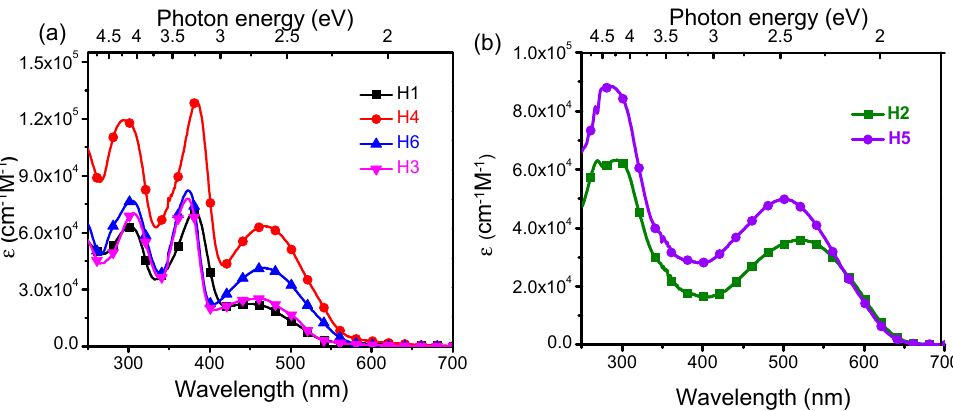
Figure 2. Absorption spectra of ( a ) H1, H3, H4 and H6 and ( b ) H2 and H5 recorded in CH 2 Cl 2. Table 1. Experimental absorption energies and molar absorption coefficients, as well as absorption energies, oscillator strengths (o.s) and transitions character from TD-DFT simulations. Sample